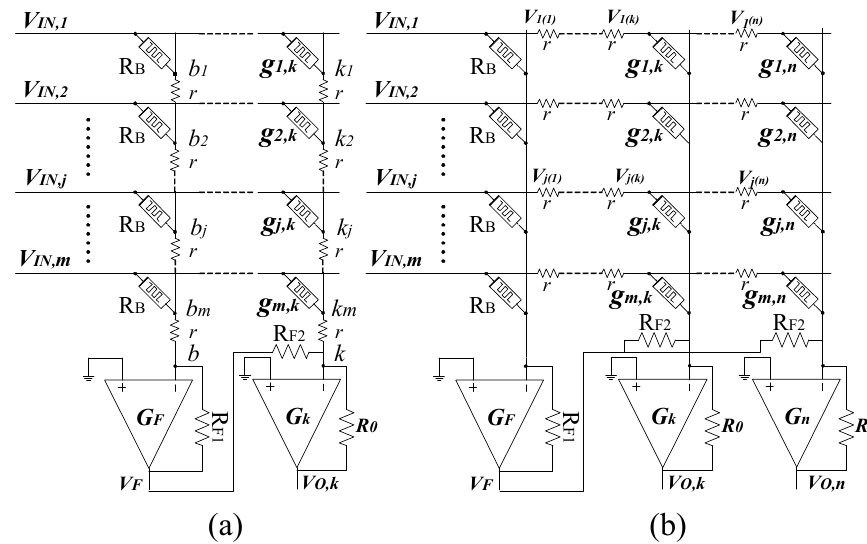
Figure 2. Wire resistance between two adjacent junctions is modeled by a small-value resistor, r, connecting between two crossing points. ( a ) Wire resistance on horizontal lines is omitted. ( b ) Wire resistance on vertical lines is omitted.